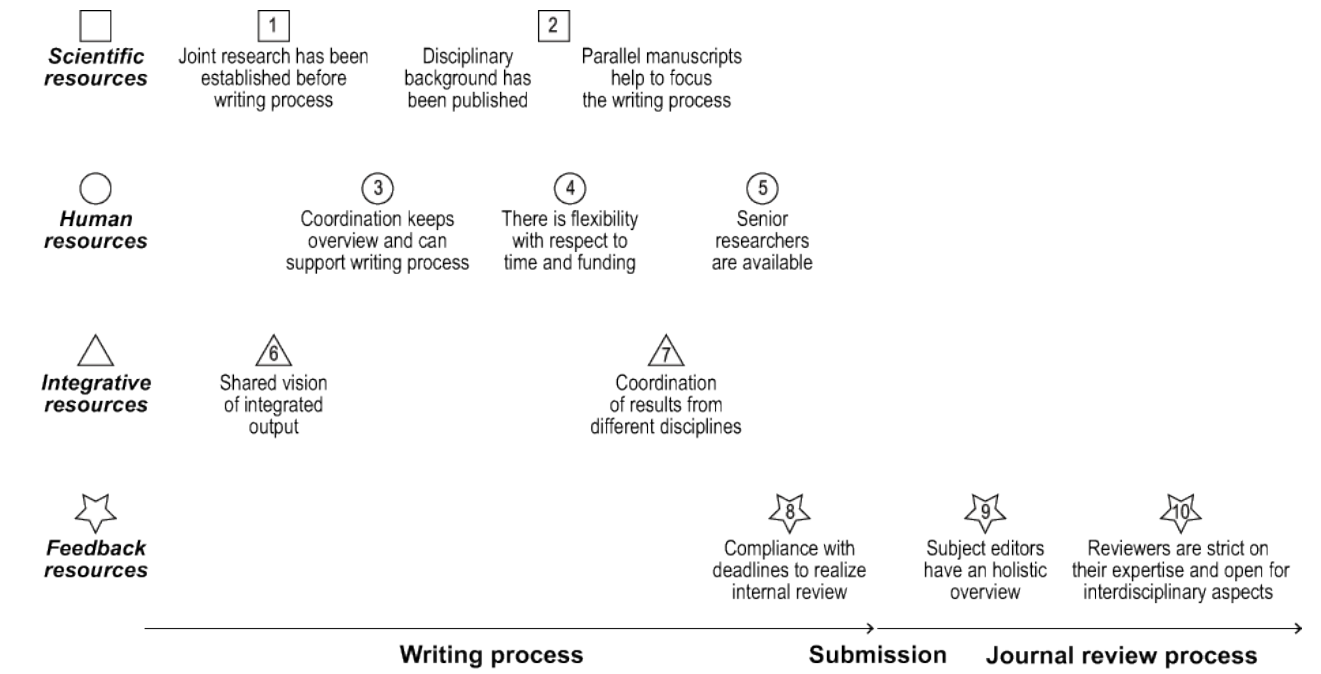
Fig. 2 . An ideal-typical storywall to publish interdisciplinary research (numbers refer to the factors described in Table